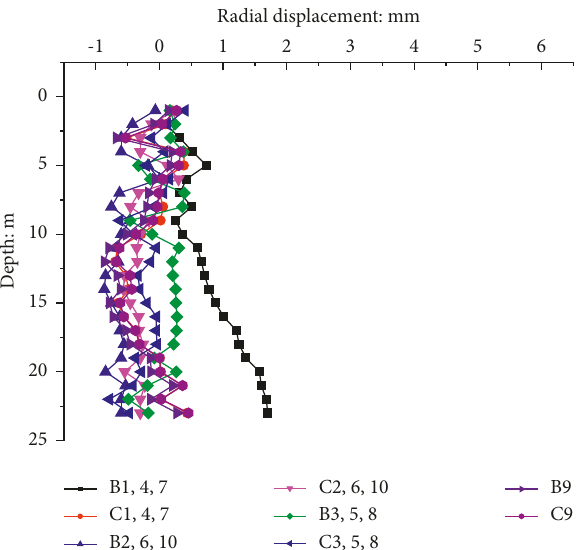
Figure 30: The horizontal displacement of # 3 measuring point changes with depth.